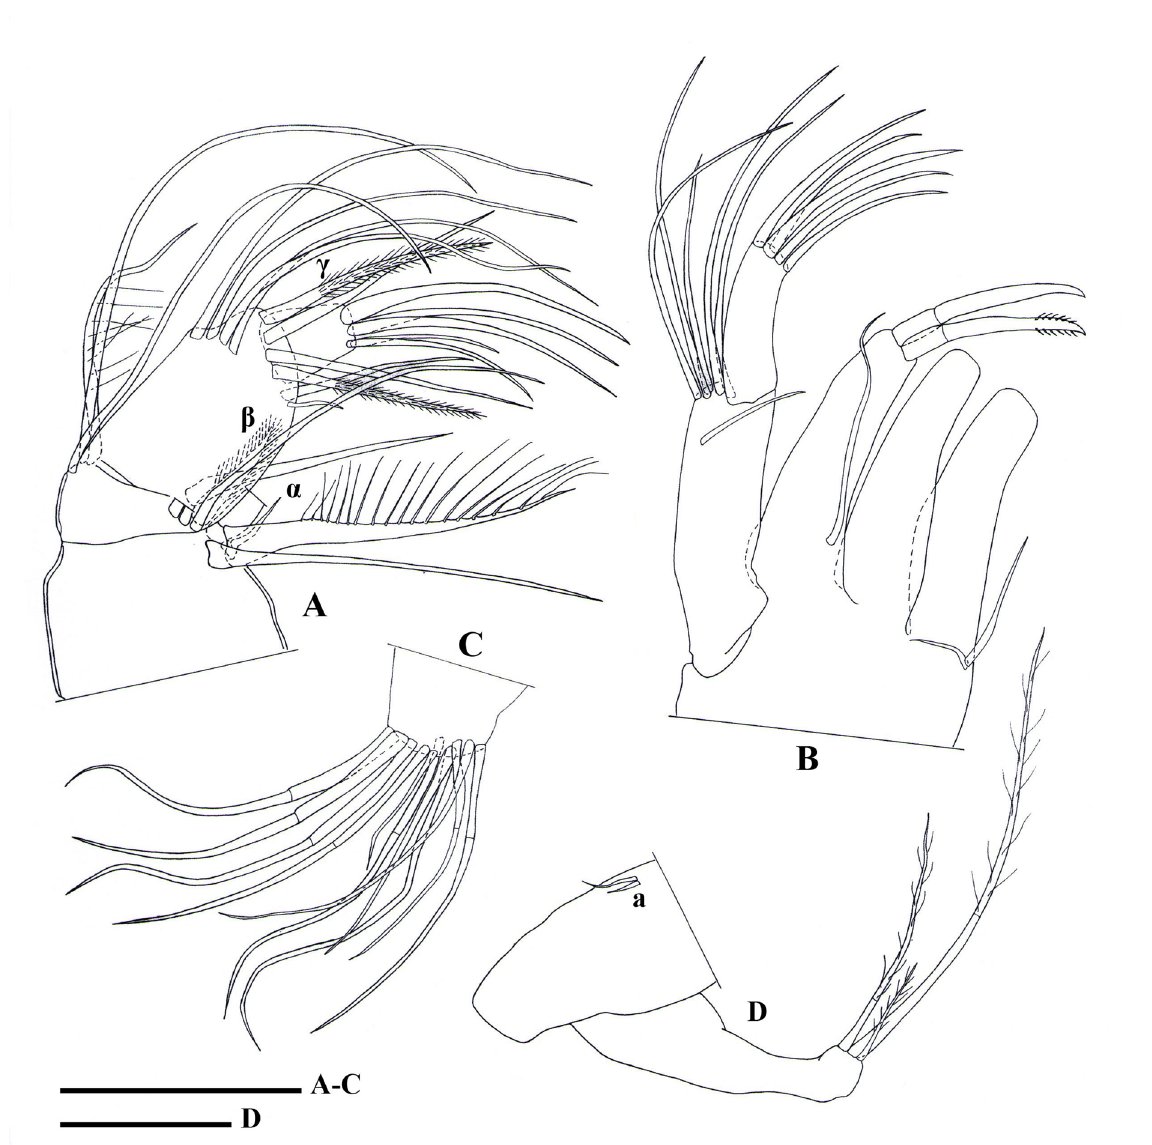
Fig. 13. Siamopsis khoratensis gen. et sp. nov., ♀ (MSU-ZOC.204). A . Md palp. B . Mx1. C . T1, apical setae on protopodite. D . T1. Scale bars: 50